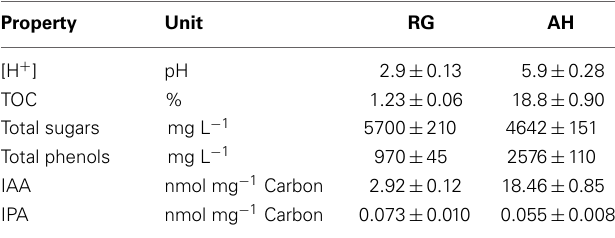
Table 1 | Chemical properties and content in the hormones of red grape (RG) and alfalfa hydrolyzed (AH) biostimulants ( n = 5; ± standard deviation).